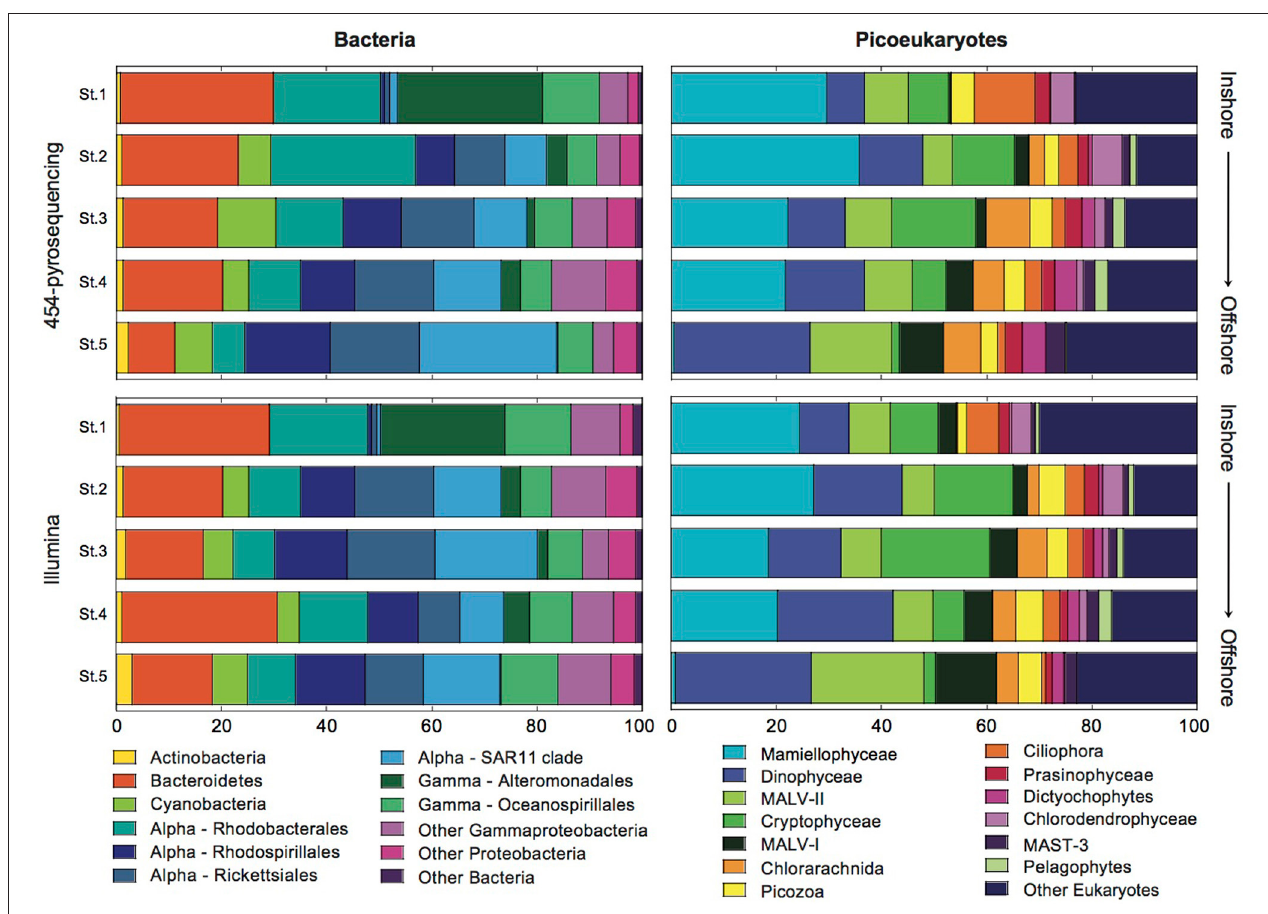
FIGURE 3 | Bar graphs showing the relative contributions of the major bacterial and picoeukaryotic taxa to community structure in the coastal (Station 1) to offshore (Station 5) transect as retrieved using 454 and Illumina